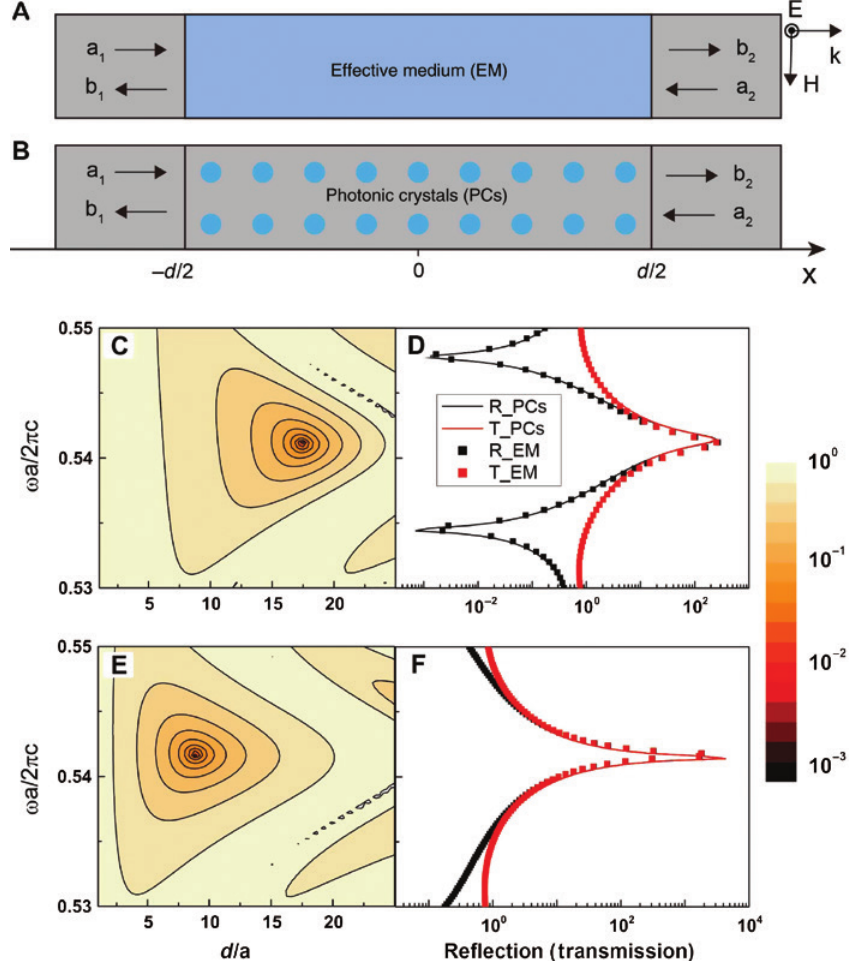
Figure 4: Scattering properties of CCM with effective parameters as shown in Figure 3. Schematics of wave scattering in (A) EM slab and (B) PC slab. The contour plot of the value 1/Max | λ , γ μ + ( ) , γ μ − ( ) . Black and red solid lines represent the reflection R and transmission T for PC slab and black and parameters (C) γ ε + ( ) and (E) γ ε − ( ) e e e e red squares represent EM slab, respectively. The non-Hermiticity strength of PCs is (D) γ d / a = 17 in (B) and d / a = 9 in